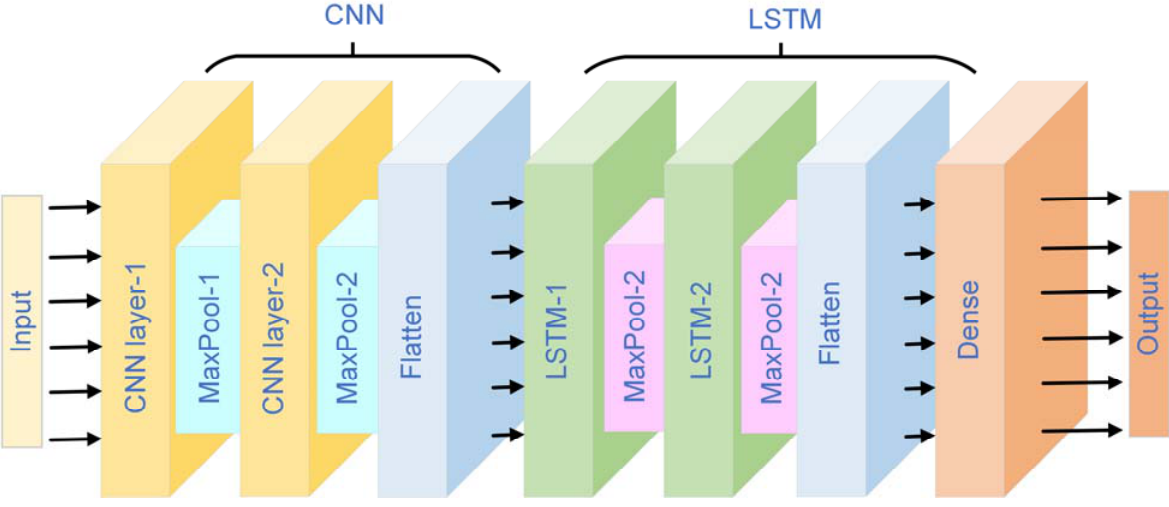
Figure 7. The frame of the CNN ‐ LSTM network for regression problems.